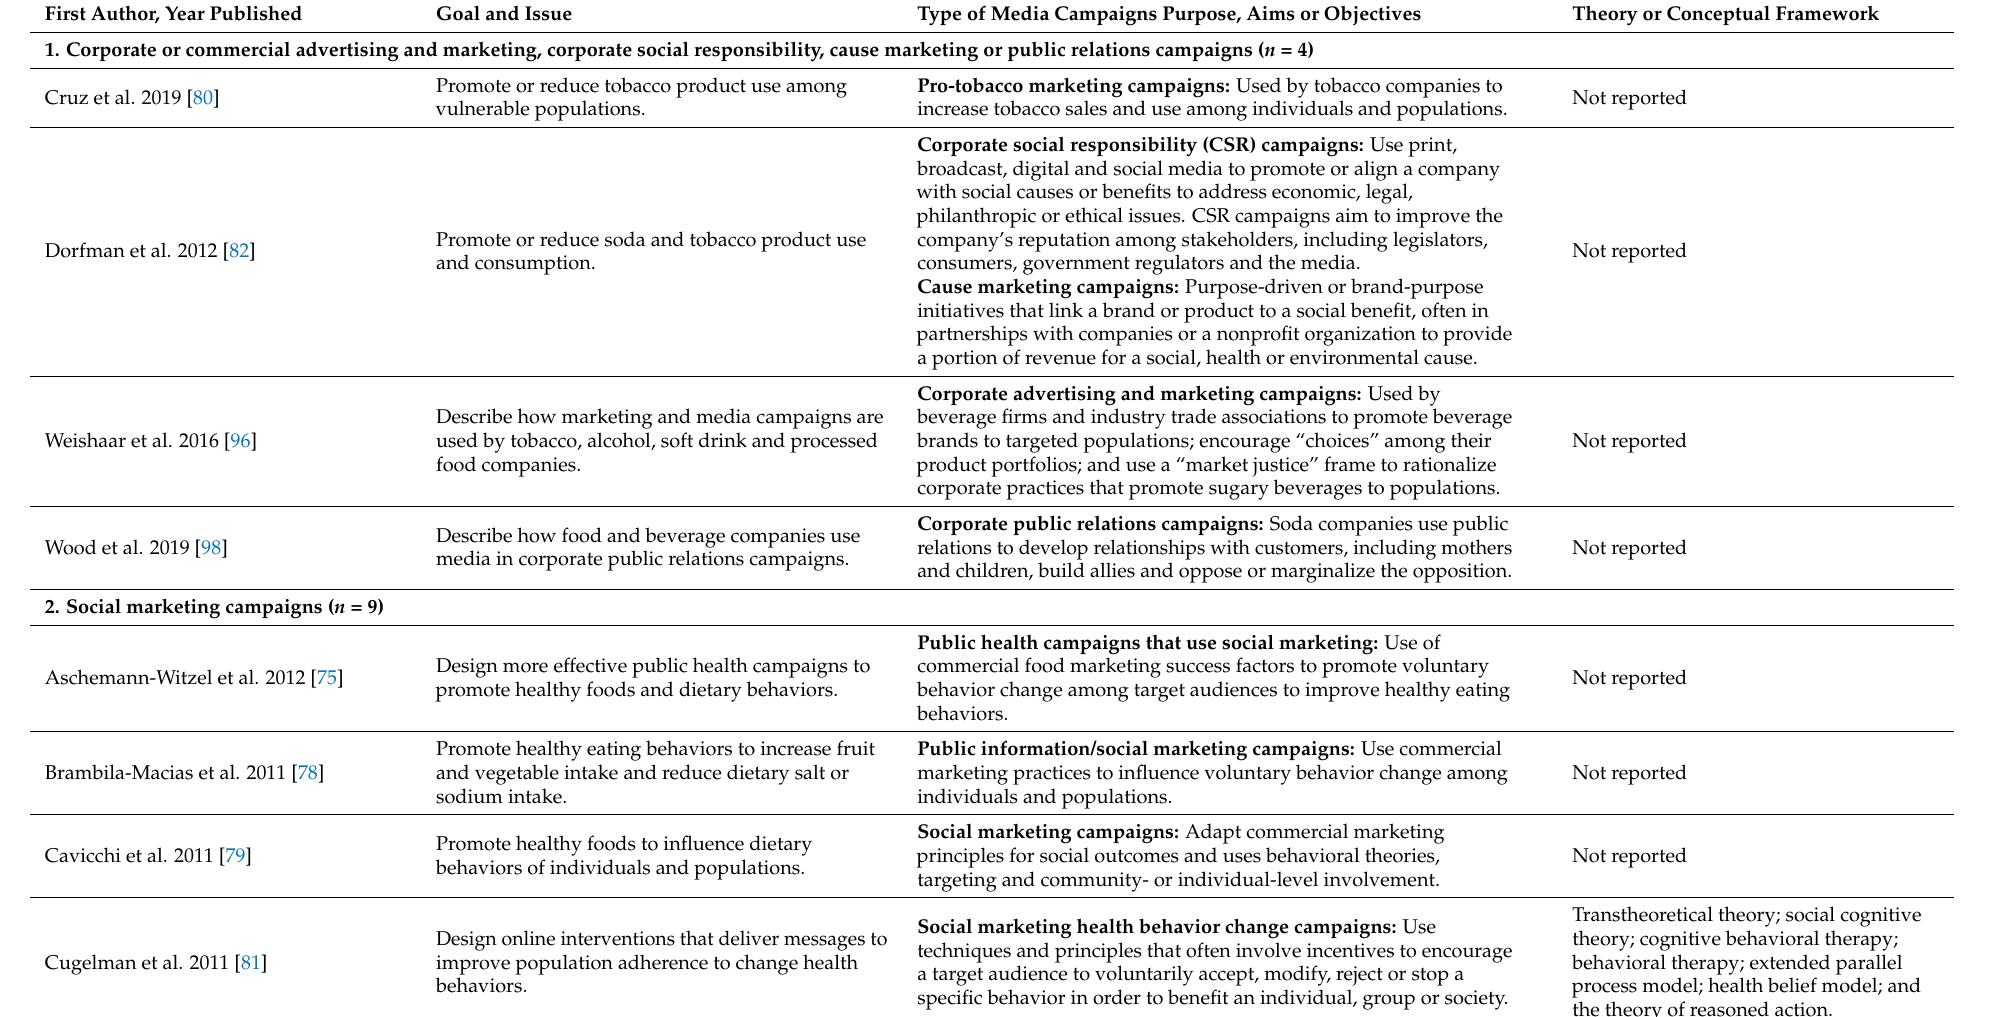
Table 2. Evidence from the scoping review of specific types of media campaigns for alcohol, tobacco, food and/or beverages defined by goal, aim or objective and underlying theory or conceptual framework,